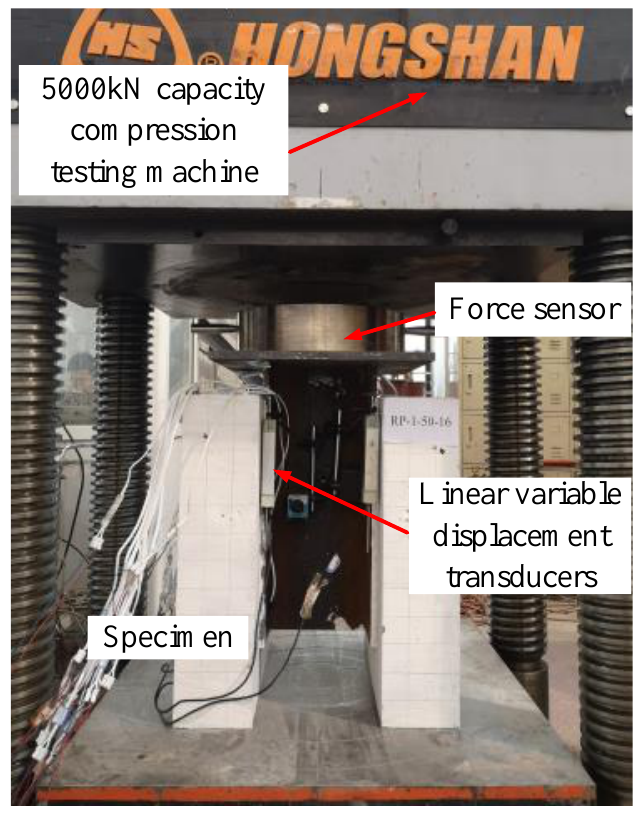
Figure 5. Loading equipment.